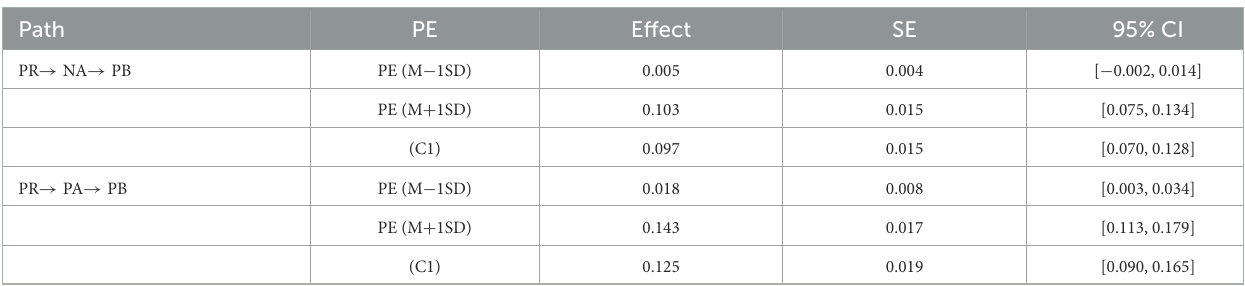
TABLE 6 Mediated moderation effect results in